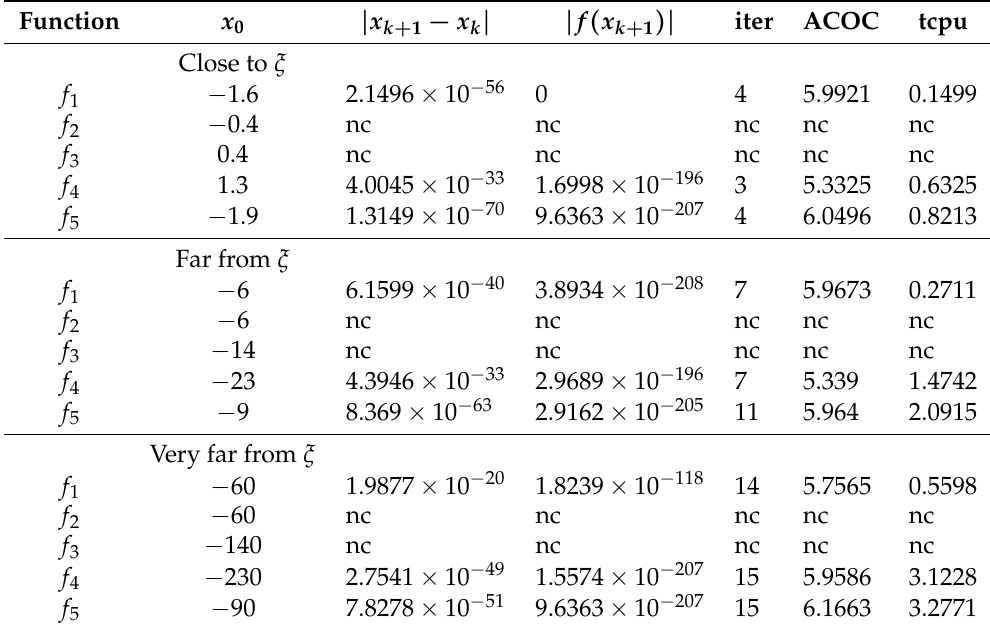
Table 8. Numerical performance of CMT (200) method in nonlinear equations.